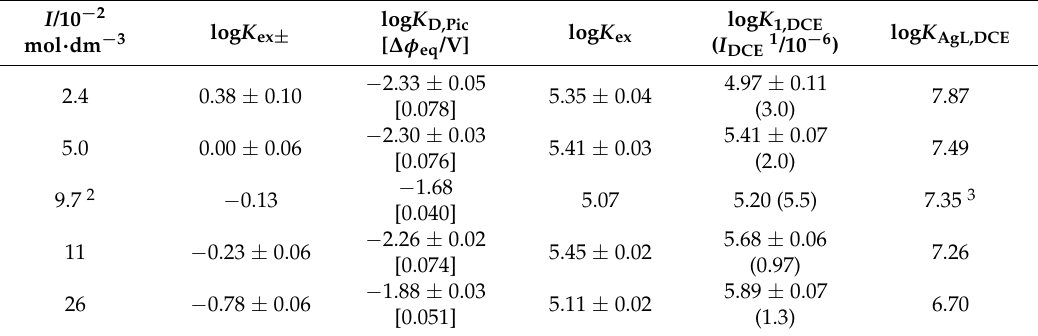
Table 2. Fundamental data for the extraction with AgPic and B18C6 (= L) into DCE in the presence of excess HNO 3 in the water phases at 298